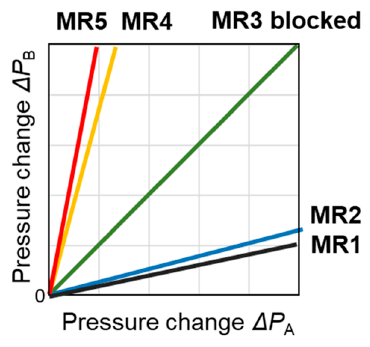
Figure 7. Pressure change diagram.